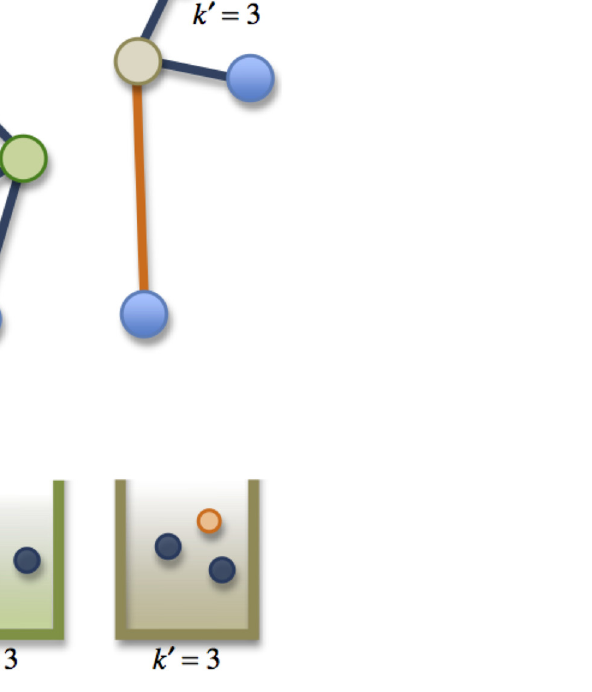
Fig 1. The Mapping of the Misanthrope Process to Rewiring Dynamics in